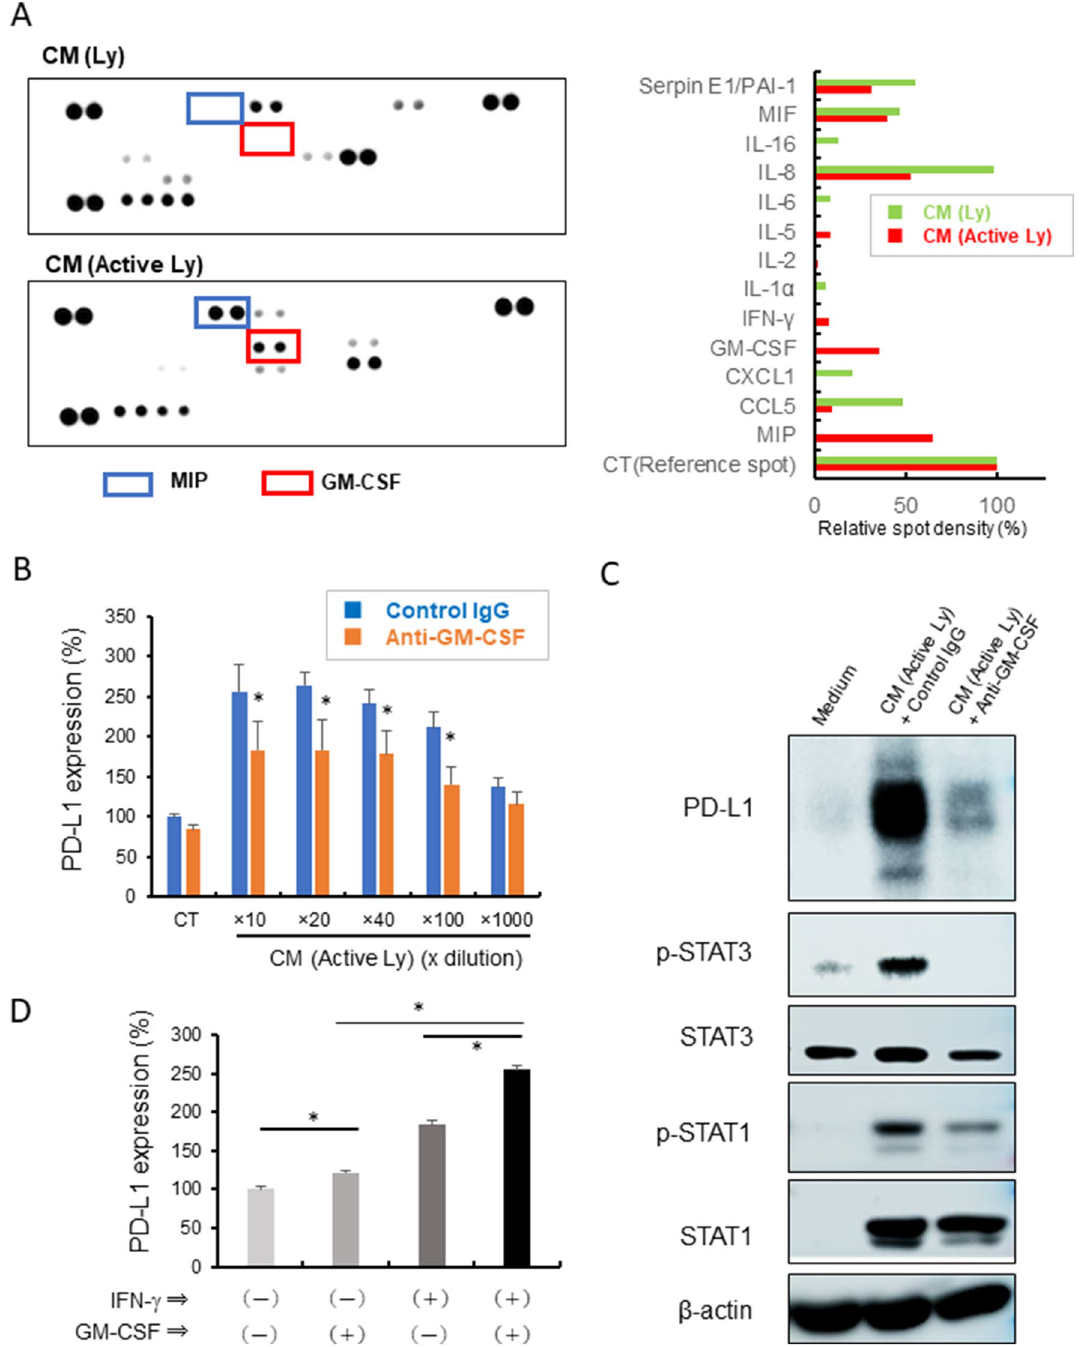
Figure 3. GM-CSF and PD-L1 expression. ( A ) A cytokine array was performed using the CMs of resting lymphocytes and activated lymphocytes. Spot densities were evaluated by Image J software. Detailed molecules listed in a membrane was presented in supplemental Fig. 6B. ( B ) HMDMs were stimulated by the CM of activated lymphocytes (Active Ly) with anti-GM-CSF antibody (20 μg/mL) or control IgG for 24 h, and PD-L1 expression was examined by a cell-ELISA assay ( n = 3 to 5 each). * p -value < 0.05. ( C ) Western blot analysis of PD-L1, pSTAT1, pSTAT3, and β-actin was performed using the lysates of HMDMs stimulated with the CMs and antibodies for 24 h. ( D ) HMDMs were stimulated with IFN-γ (20 ng/mL) and GM-CSF (5 ng/mL) for 24 h, and PD-L1 expression was examined by a cell-ELISA assay ( n = 4 each). *; p value =